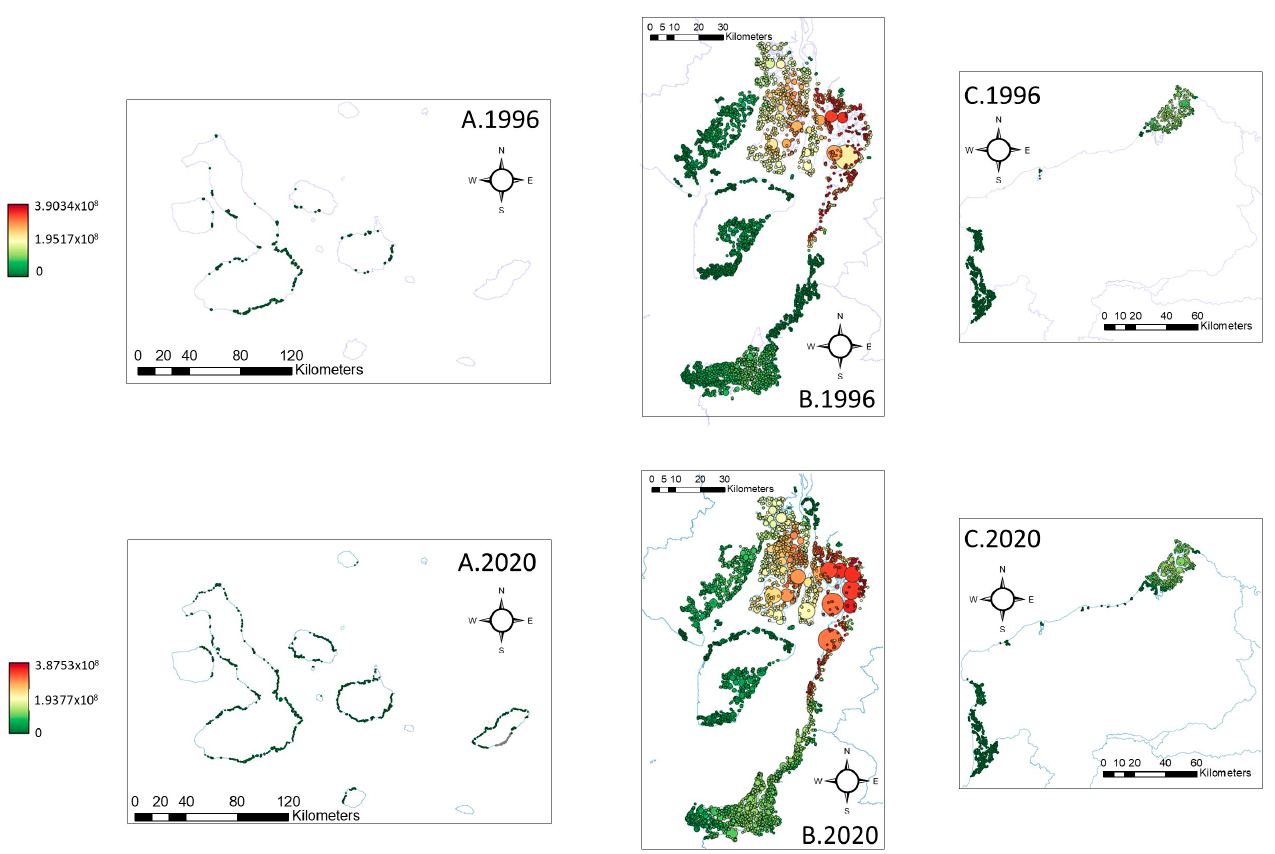
Figure 6. Connectivity of Ecuadorian mangrove forests per patch in the years 1996 and 2020. The size of the circle indicates the size of the patch and the color its connectivity. ( A ) Galapagos. ( B ) Guayas and the El Oro region. ( C ) North of Manabí and Esmeraldas.